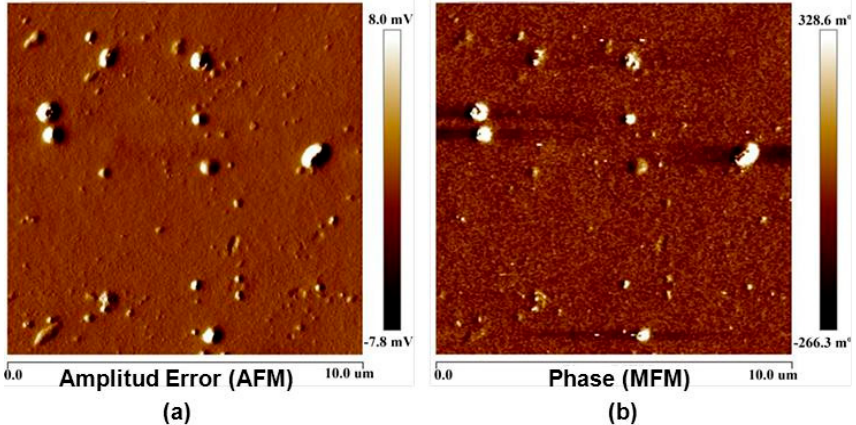
Figure 4. PDMS/MWCNT/CoFe 2 O 4 cured in the presence of H (MWCNT: 1% w/w ; CoFe 2 O 4 : 2% w/w ). ( a ) AFM image. ( b ) MFM image. Exactly the same region of a given sample was scanned using the two techniques. The coincidence between both images suggests that the magnetic and non-magnetic materials were grouped to form clusters, as also observed by SEM in Figure 3.